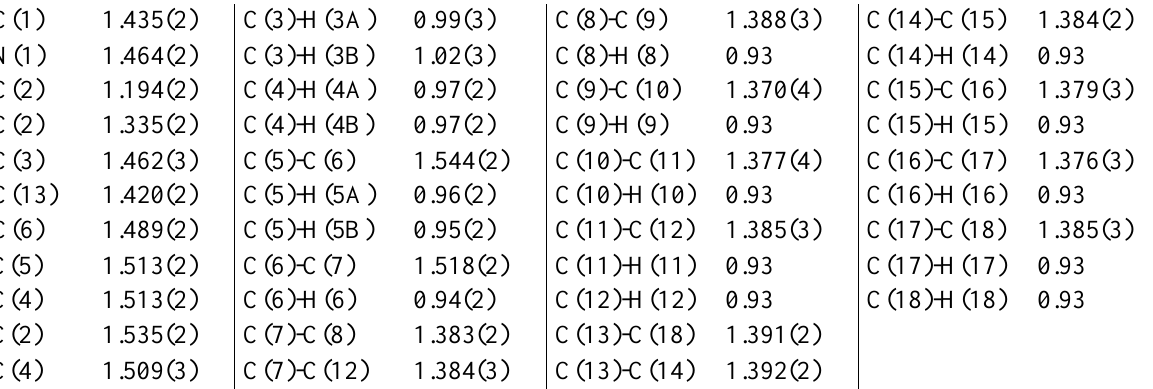
Table 1. Bond lengths [Å] for 3a .